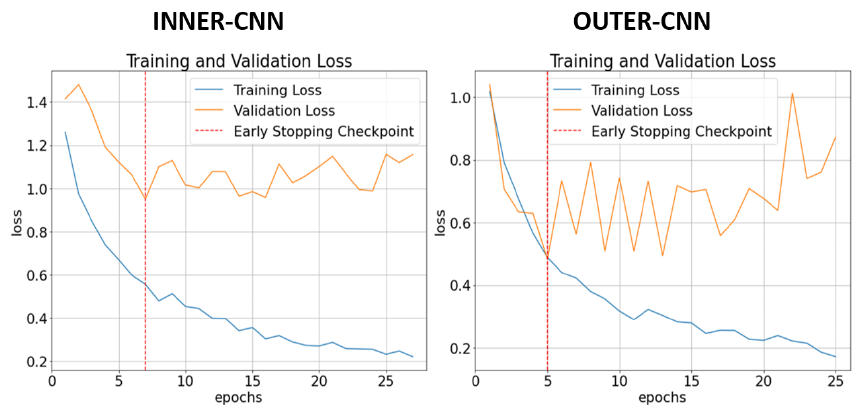
Figure A2. The training and validation losses of training the models: INNER-CNN ( left ) and OUTER- CNN ( right ). On the y -axis the loss and on the x -axis the number of epochs. The red dotted line indicates the early stopping point.